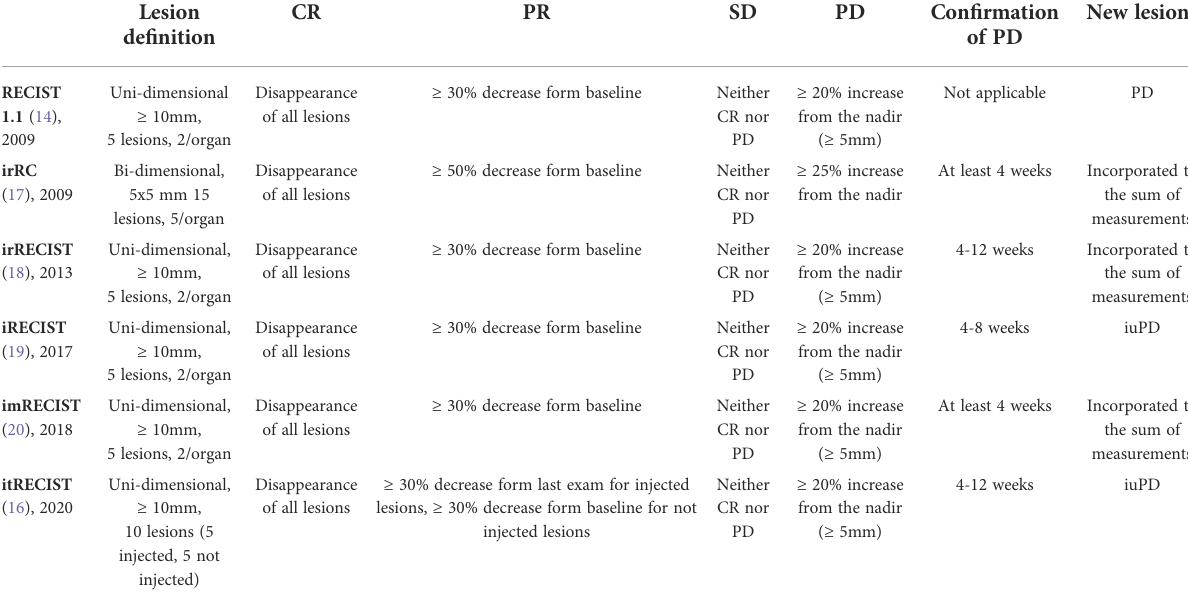
TABLE 1 Morphologic criteria for the assessment of response to